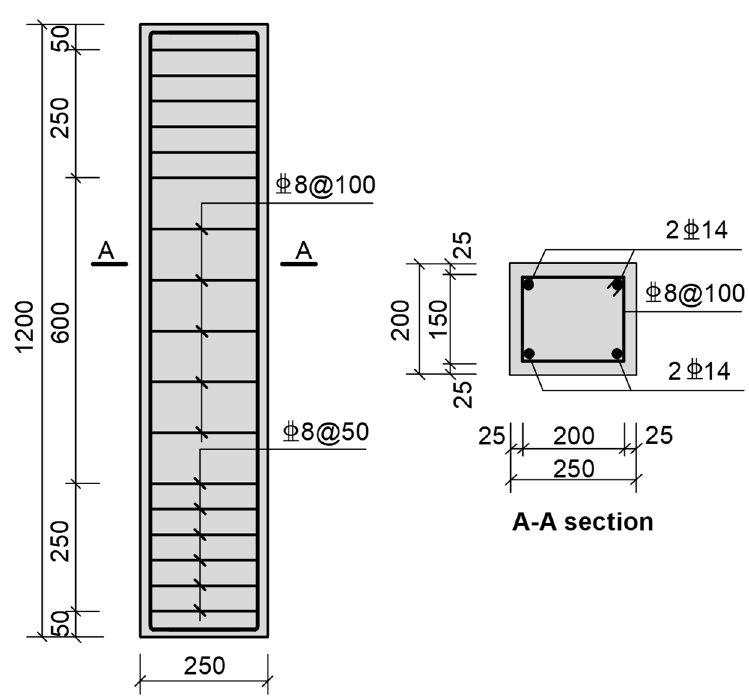
Figure 1. Geometry and reinforcement details of RC columns (Dimensions in mm).